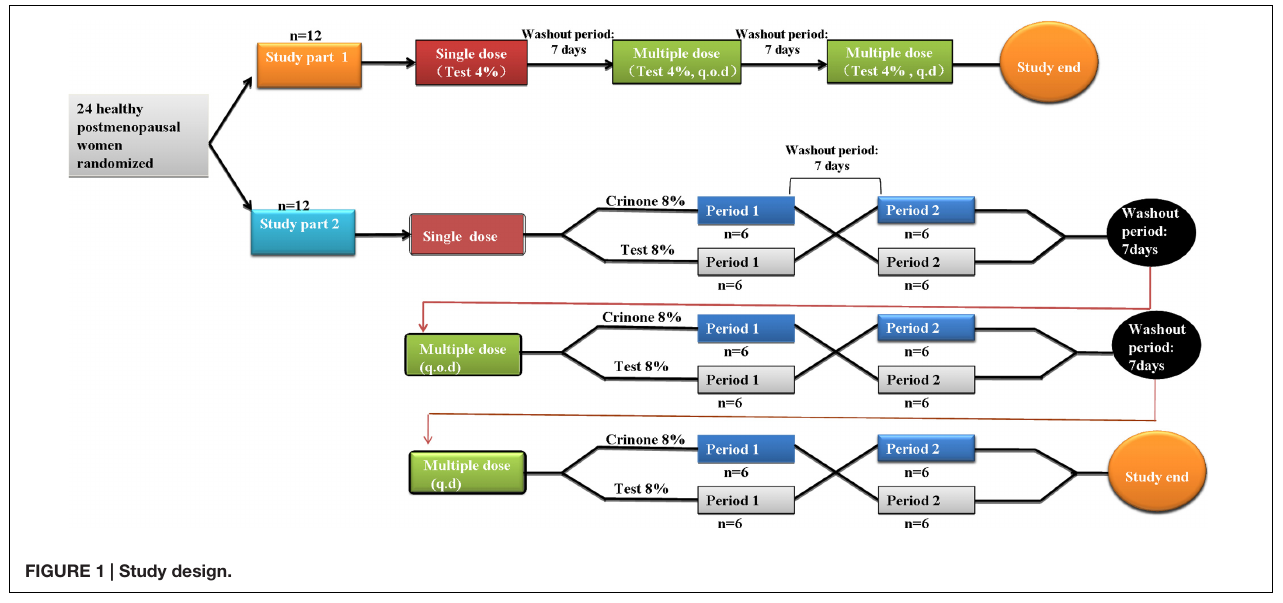
FIGURE 1 | Study design.